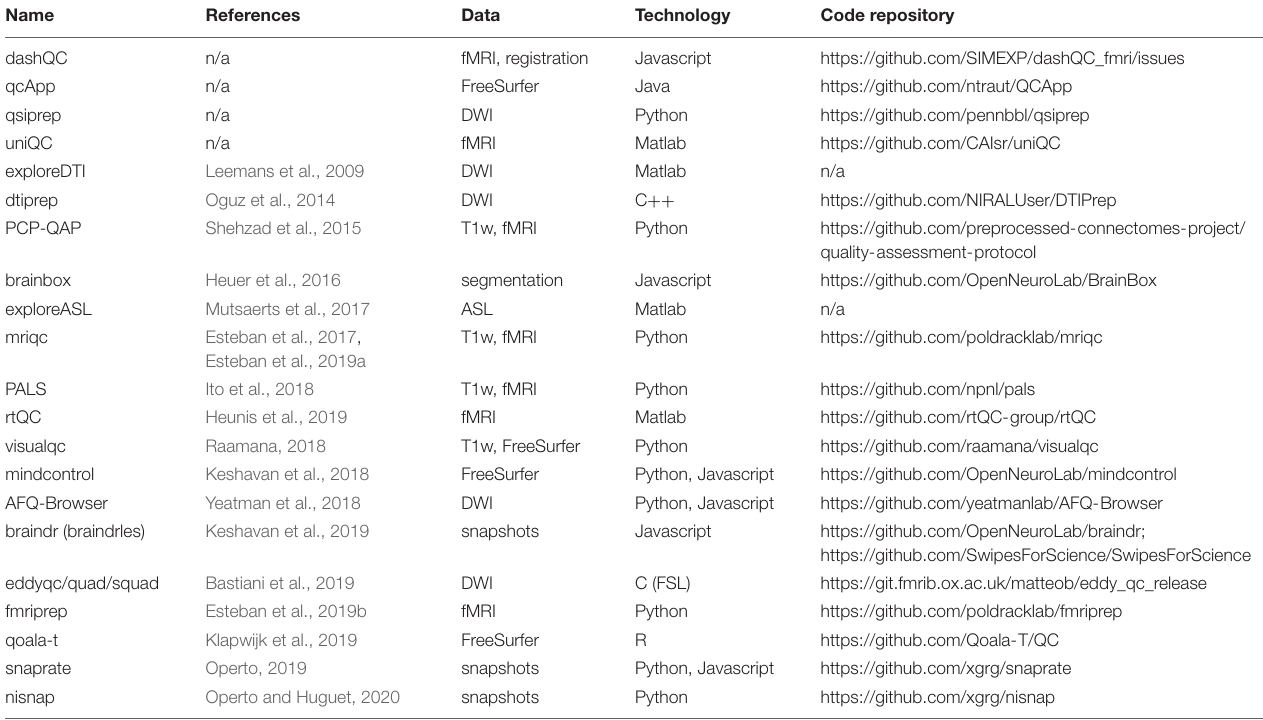
TABLE 1 | List of currently available resources intended for quality control of neuroimaging data (adapted from